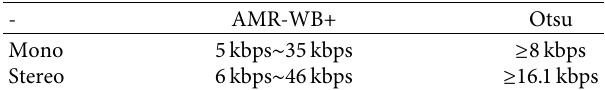
Table 3: Two-dimensional Otsu threshold segmentation fast it- erative algorithm.